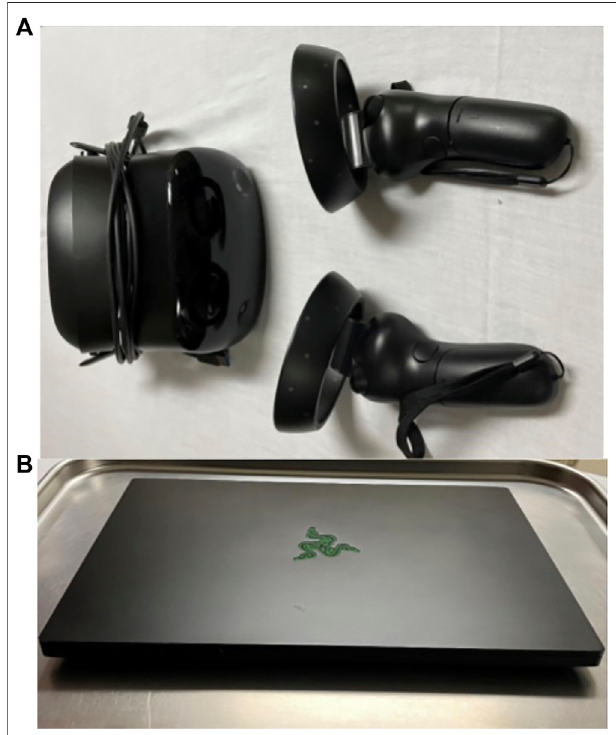
FIGURE 1 | VR Simulator Setup: ( A) Microsoft Mixed Reality headset and joysticks and (B) Razor Blade 15 laptop with Intel Core i7-8750H CPU